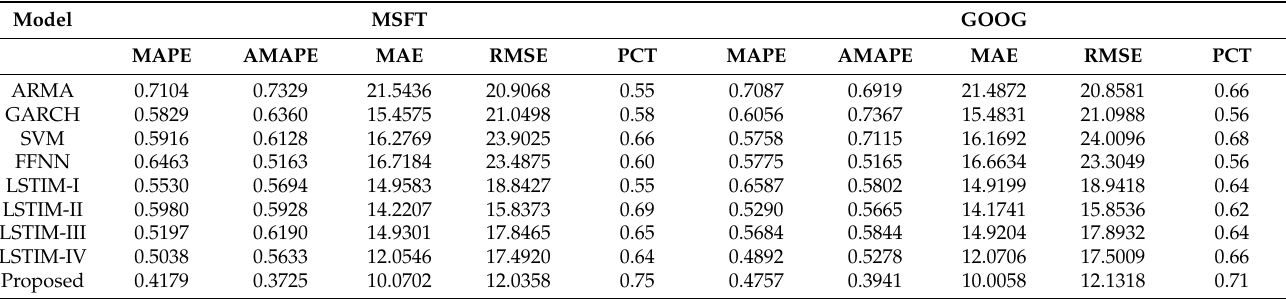
Table 11. Prediction performance for 150 days: MSFT and GOOG.